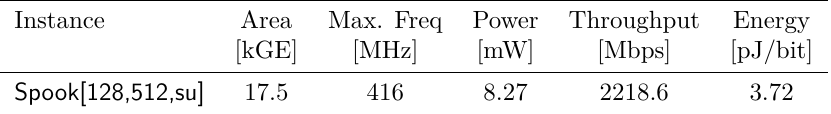
Table 11: ASIC implementation results (post place-and-route) with N u =